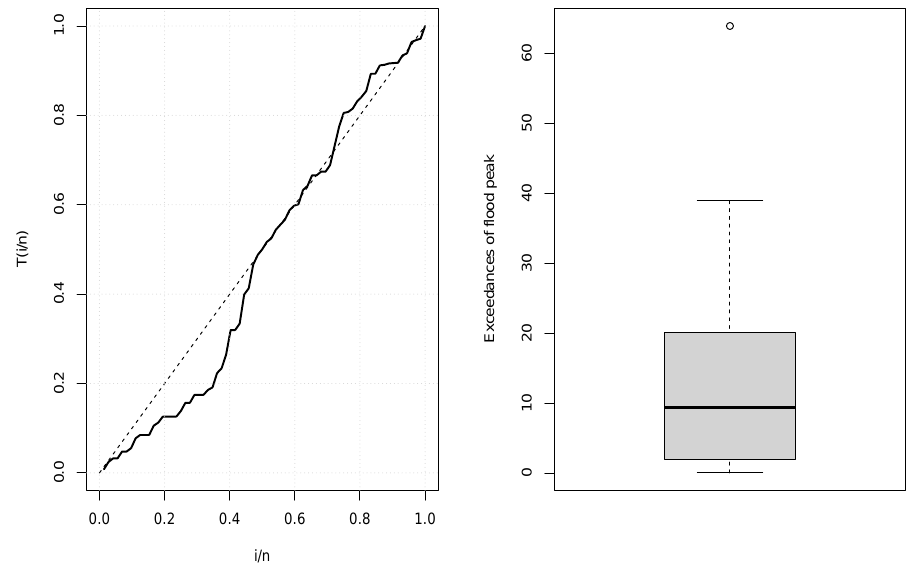
Figure 3. TTT plot ( left ) and box plot ( right ) based on the Wheaton river data.